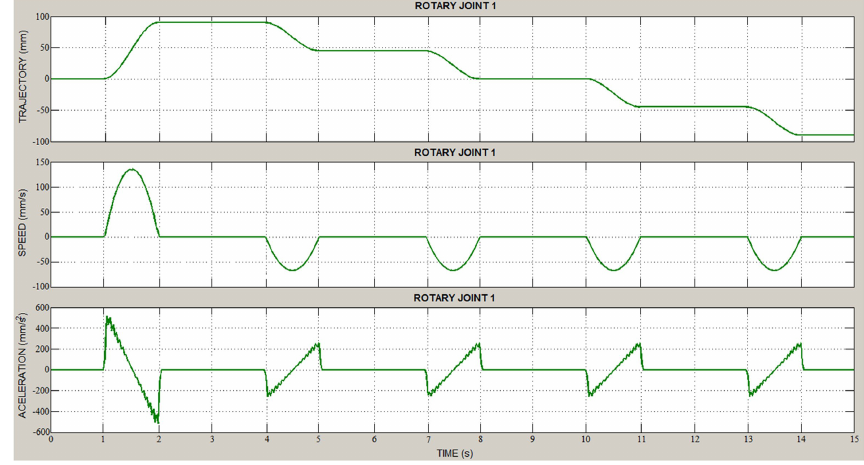
Figure 10. Dynamic performance curves of the first rotary joint. Position, speed, and